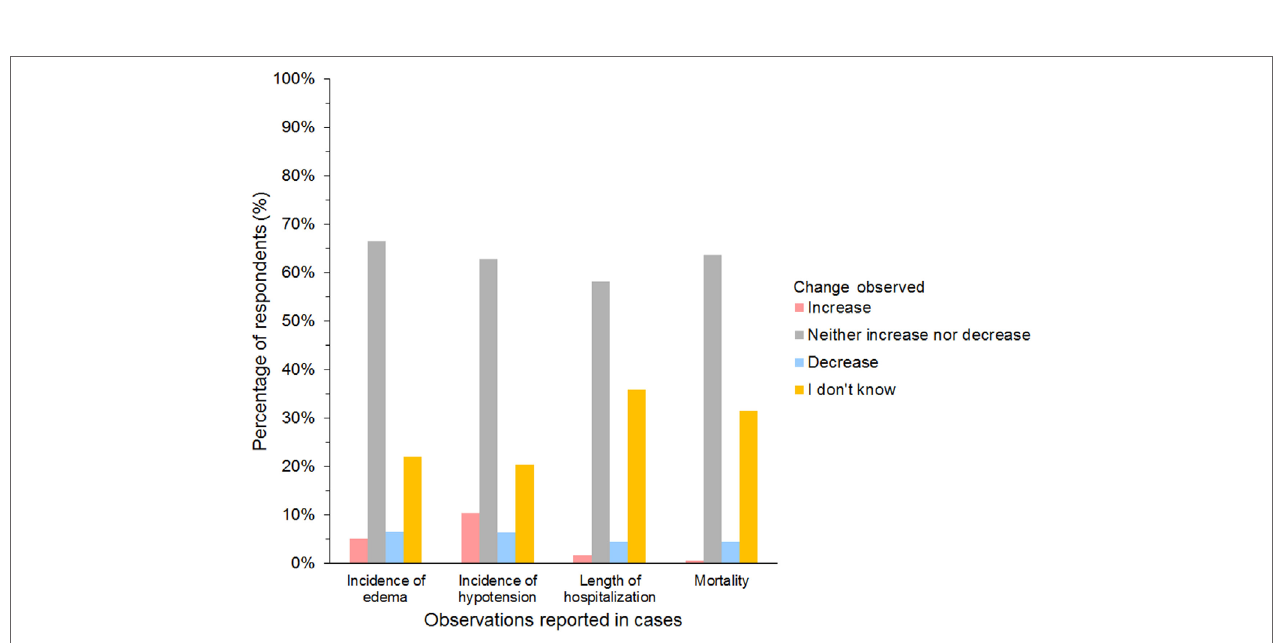
FigUre 10 | Frequency chart showing the changes in synthetic colloid use over the past 5 years and/or because of new recommendations reported by survey respondents (650 hydroxyethyl starch users; 27 gelatin users; 11 dextran